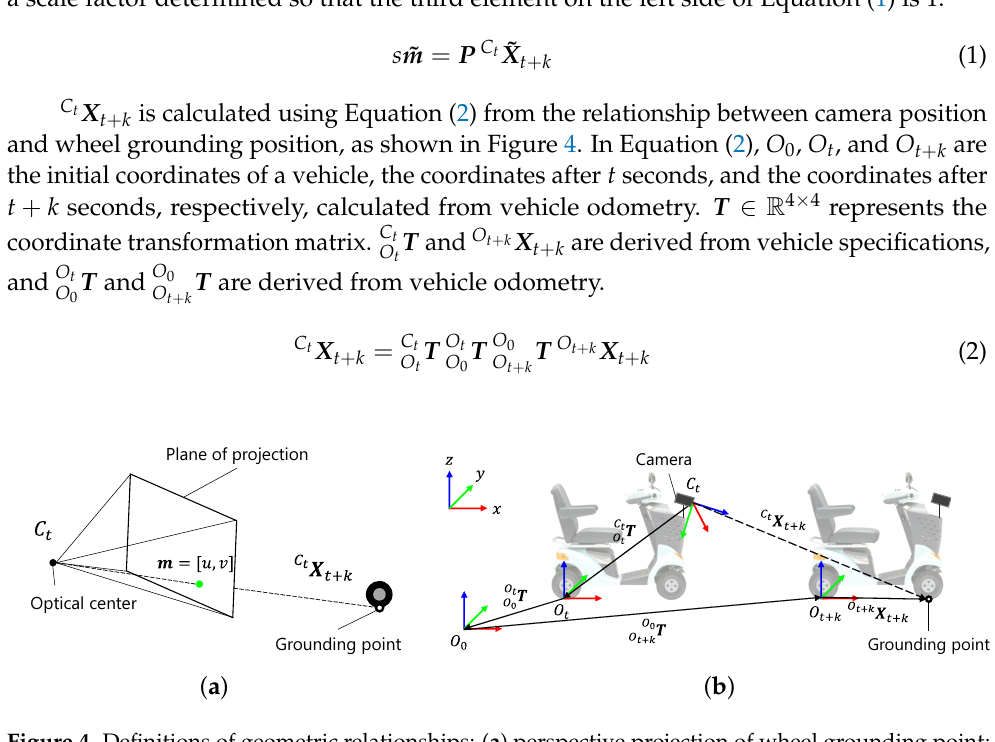
Figure 4. Definitions of geometric relationships: ( a ) perspective projection of wheel grounding point; and ( b ) coordinate origin and coordinate transformation for deriving C t X t + k